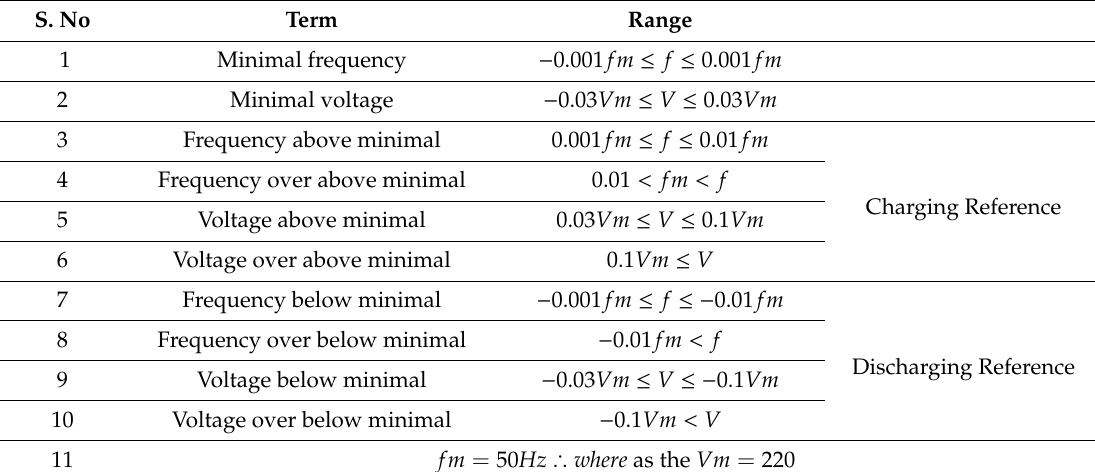
Table 1. Nominal values of voltage and